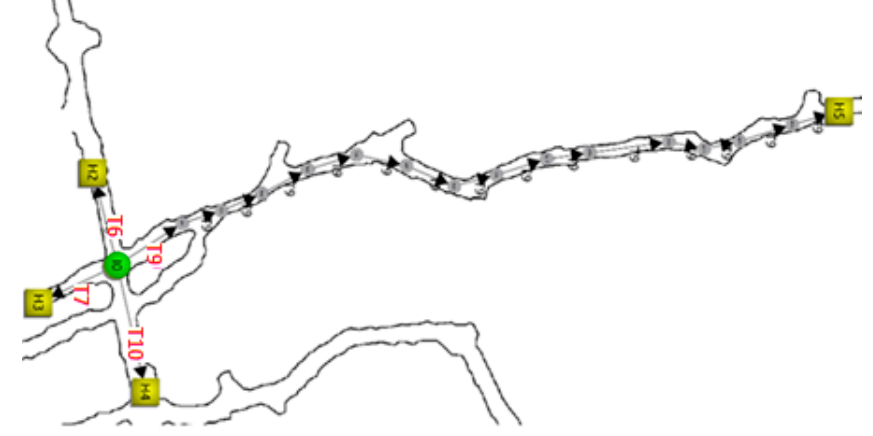
Figure 3. Example of a topological map of a real mine.